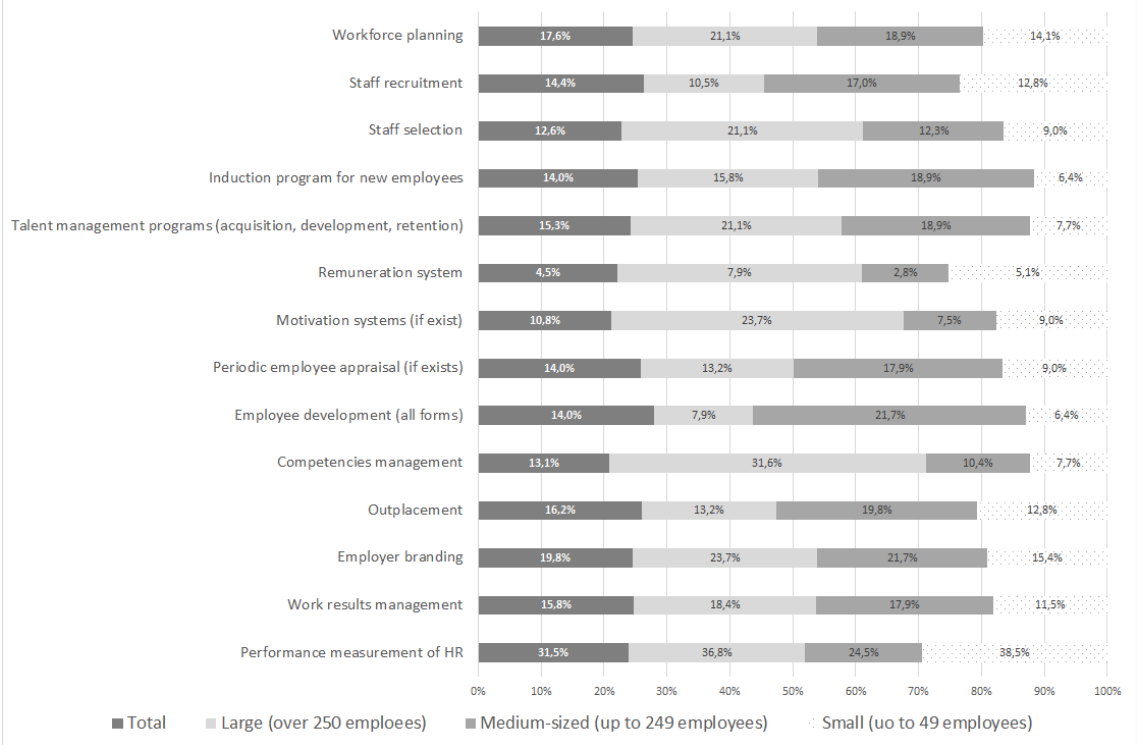
Figure 6. HR management practices planned to be implemented by surveyed firms. Source: authors’ original work.